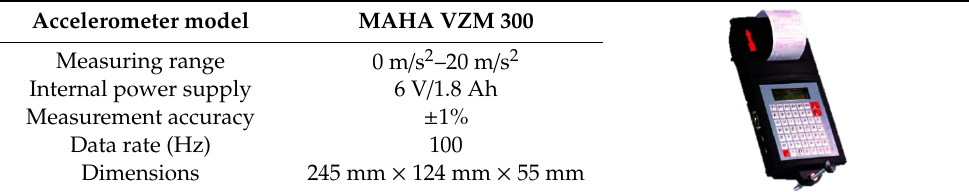
Table 3. Technical information of the accelerometer MAHA VZM 300.